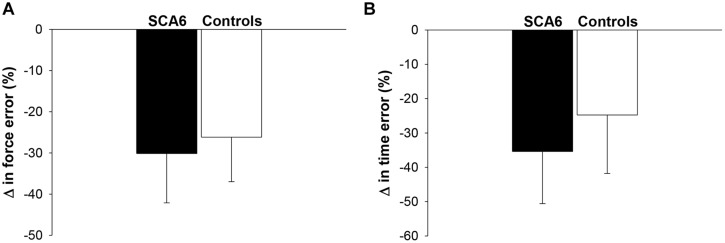
Changes in force and time error during task acquisition. The change in force error (A) and time error (B) from the first block to the last block of practice was similar for SCA6 participants and healthy controls.